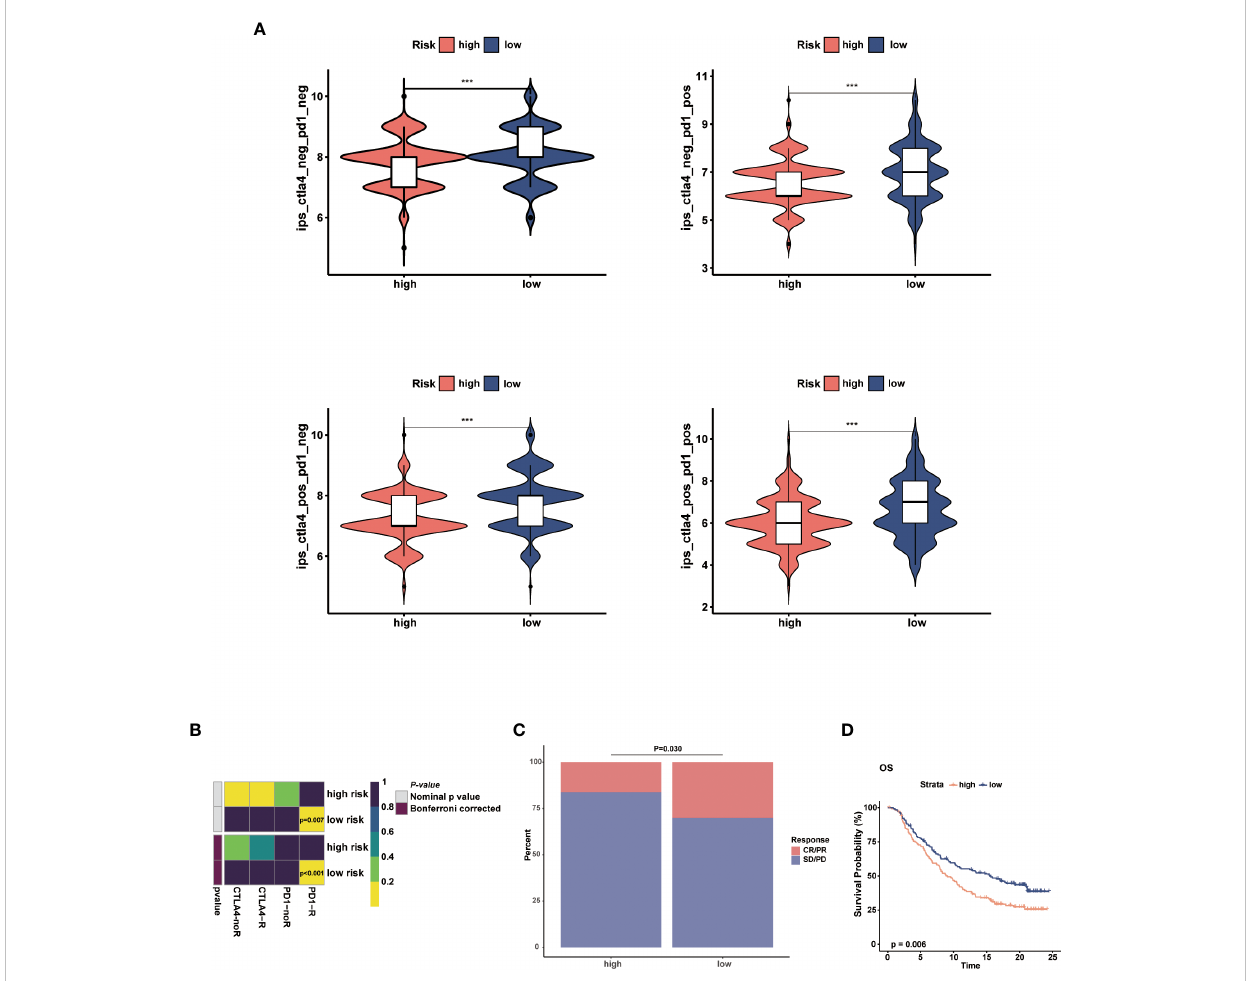
FIGURE 9 Prediction of the immunotherapy response in the two risk groups. (A) Comparisons of the IPS in the two risk groups. (B) Submap analysis between the two risk groups. (C) The proportion of clinical response to anti-PD-L1 immunotherapy in different risk groups in iMvigor210 cohort. (D) KM curves for the low-risk and high-risk groups in the iMvigor210 cohort. ***